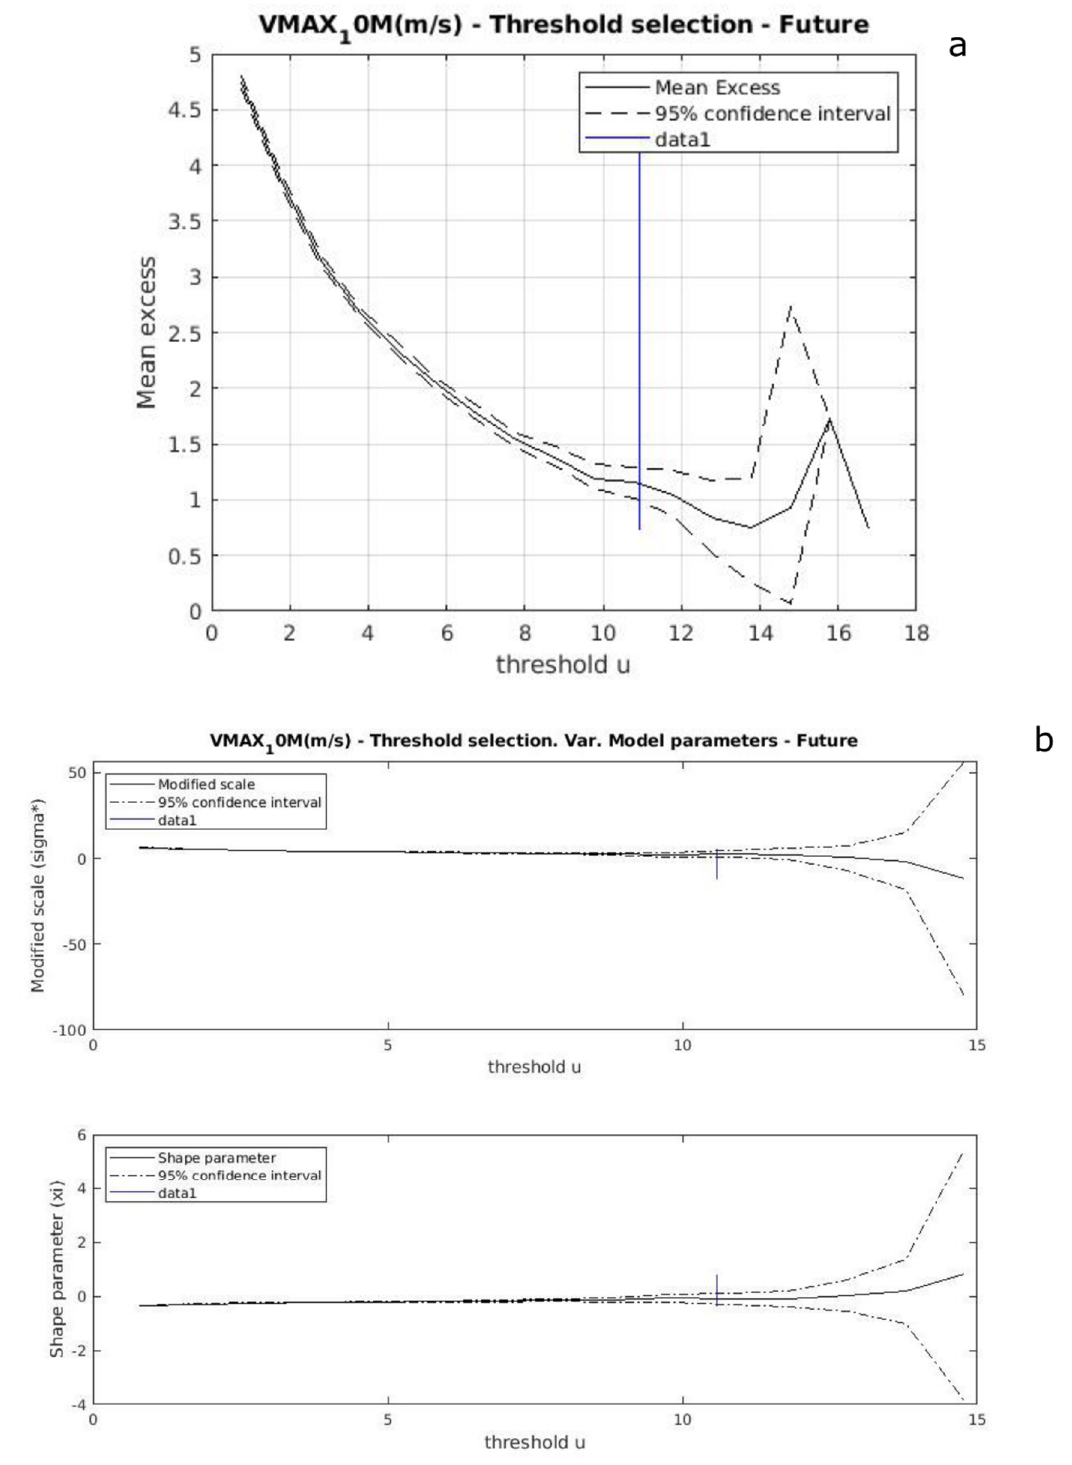
Figure A2. Graphs for the identification of the threshold for POT analysis of wind data for the historical period reference (2020–2049). ( a ) Graph of the “mean residual life” as a function of the threshold u . ( b ) Graphs of model parameters ( σ * e ξ , respectively) for evaluating their stability with the variation of the threshold u .